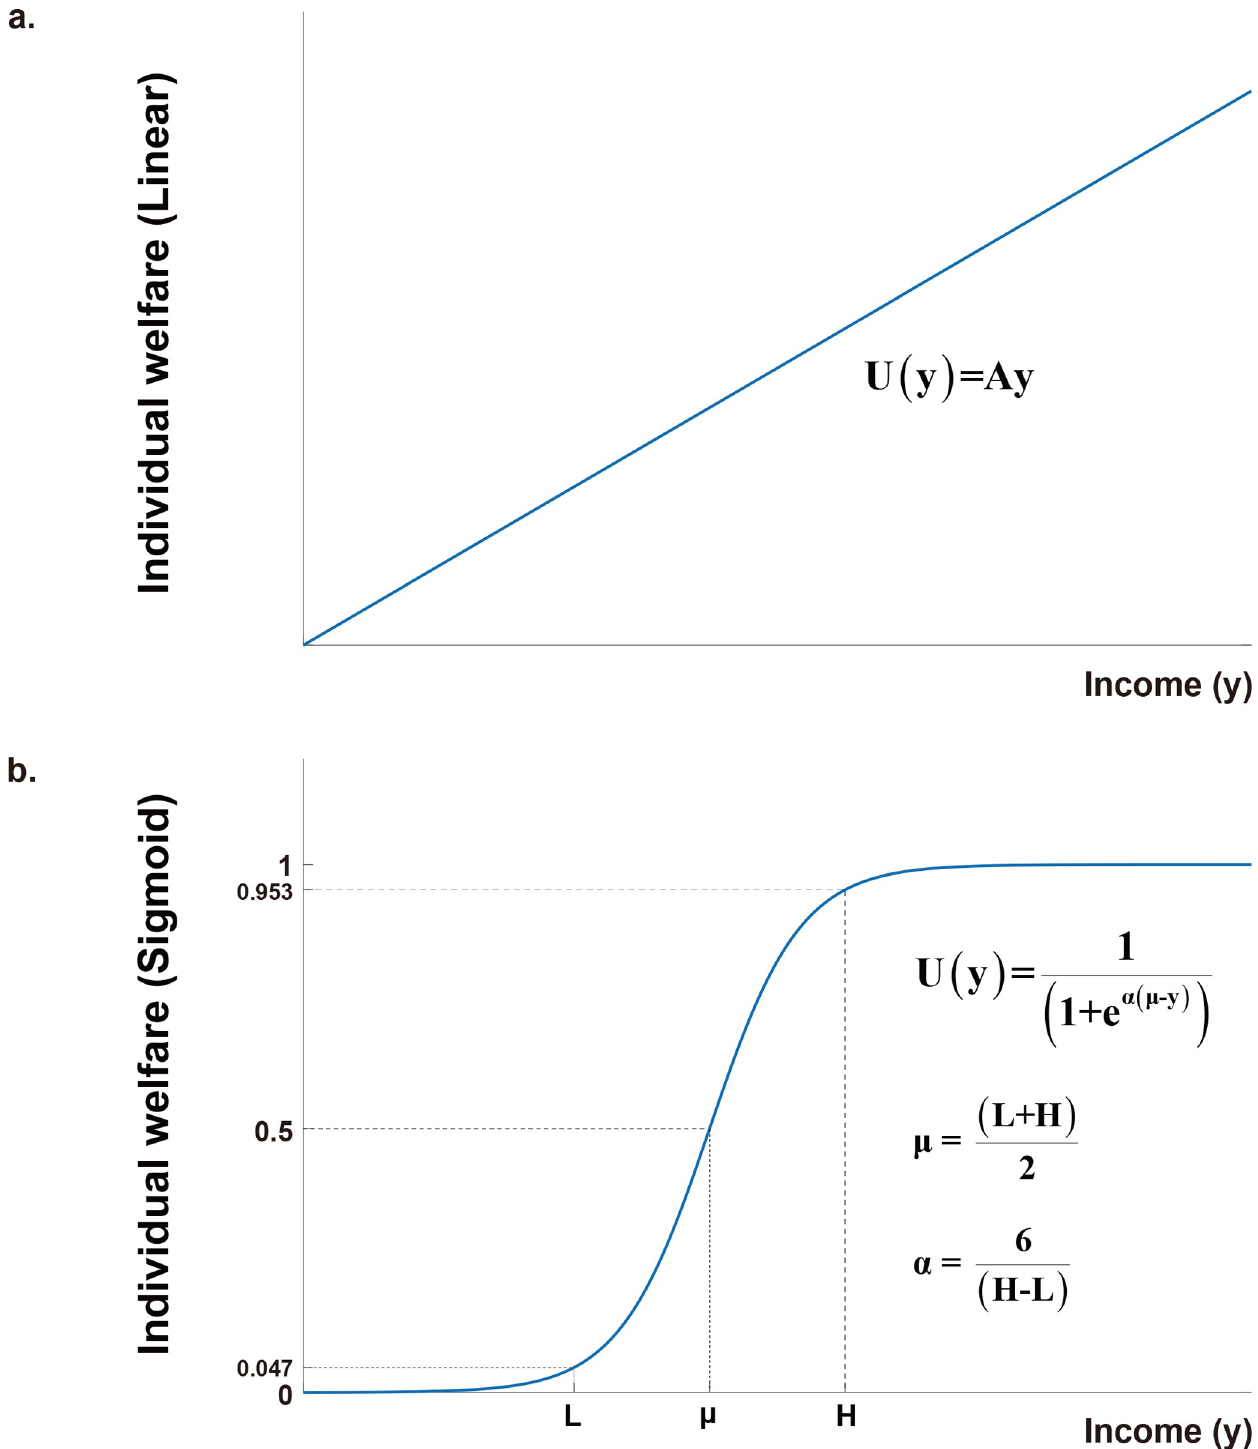
Fig 2. Individual welfare functions as a function of income. (a) The linear function used in the Utilitarian social welfare. (b) The non-linear sigmoid function, reflecting more realistic individual welfare as income increases. With the critical low- and high- income values ( L and H ), the two constants ( μ and α ) in the sigmoid function can be